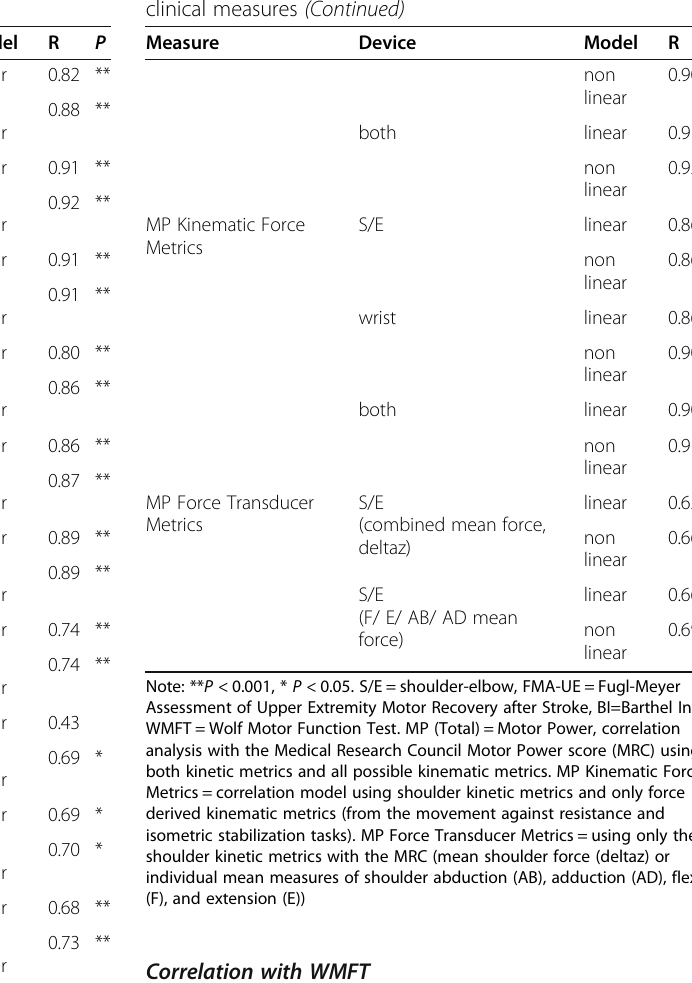
The same 6 shoulder-elbow and 5 wrist and forearm metrics as the FMA-UE correlation were found to have a R > .5 for the WMFT correlation analysis.